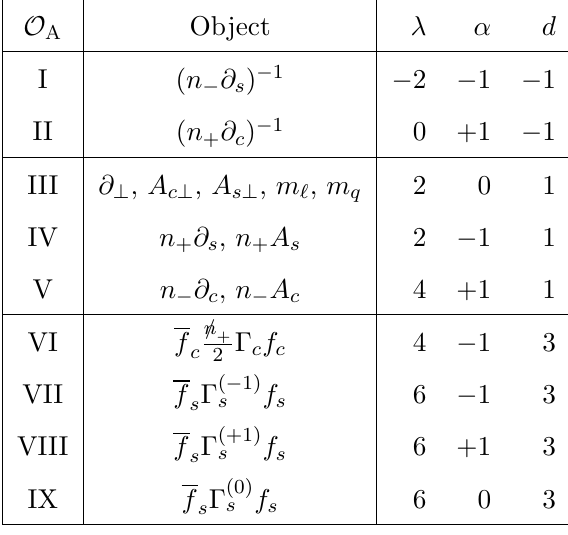
Table 5. Building blocks that can be added to (B.6). The column (cid:21) denotes the (cid:21) scaling of the object, (cid:11) its scaling under type-III reparametrizations, and d its canonical dimension. The Dirac matrices (cid:0) are de(cid:12)ned in table 4. The counting refers to matching of the hard-collinear sector. The SCET I operator (cid:31) h v ‘ hc ‘ , which is generated in the matching of Q 9 ; 10 to hc hc SCET I , has d = 6 and boost scaling (cid:11) = 0. Requiring these to match those of